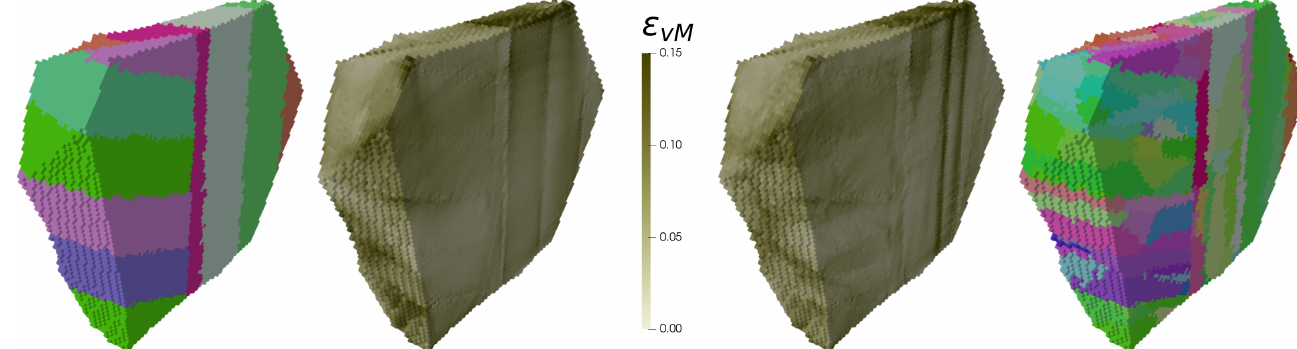
Figure 11. Inverse Pole Figure (IPF) (for color legend see Figure 2a) and equivalent strain of a part of the generated microstructure corresponding to 3D RVEs with θ max = 0° ( left ) and θ max = 5° ( right ). Two packets belonging to a prior austenite grain are distinguishable.